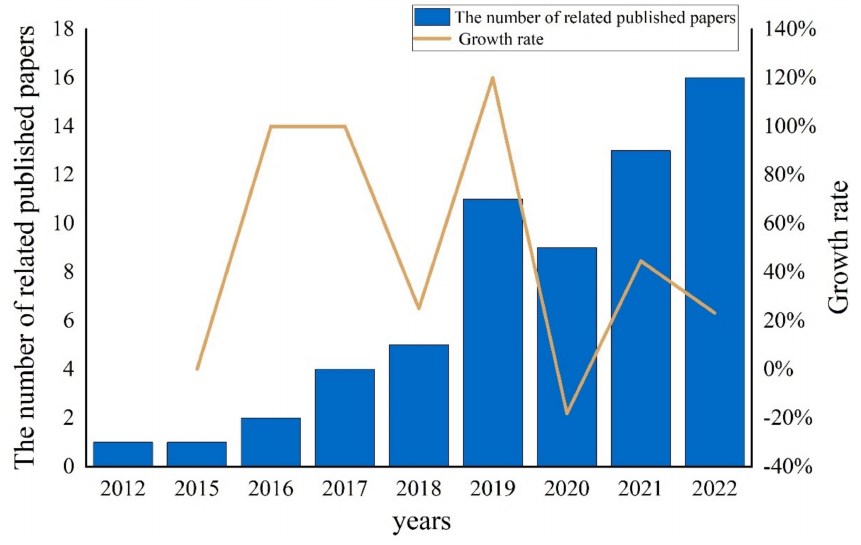
Figure 4. Statistics of published papers on collision-detection